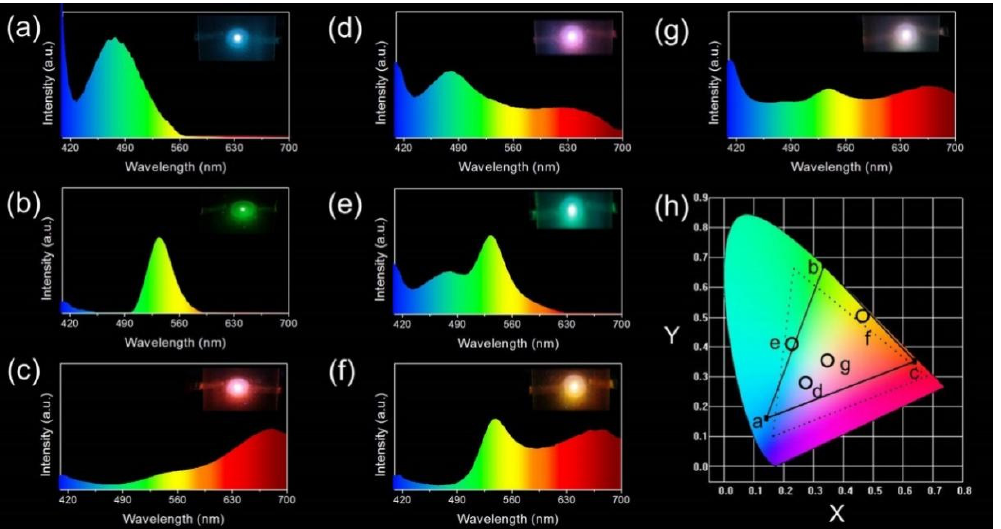
Figure 5. The emission spectra of the remote LEDs based on monolayer and multilayer MNCs/PVA films: ( a ) Cu-MMI/PVA film, ( b ) Au-ATT/PVA film, ( c ) Au-BSA/PVA film, ( d ) Cu-MMI/PVA film and Au-BSA/PVA film, ( e ) Cu-MMI/PVA film and Au-ATT/PVA film, ( f ) Au-ATT/PVA film and Au-BSA/PVA film and ( g ) Cu-MMI/PVA film, Au-ATT/PVA film, and Au-BSA/PVA film. Insets of ( a − g ) are the corresponding photographs of the remote LEDs. ( h ) The CIE chromaticity coordinates of the LEDs in ( a – g ). The dashed line is the range of color gamut of NTSC and the solid line is the color coverage of the LED based on our MNCs/PVA films.